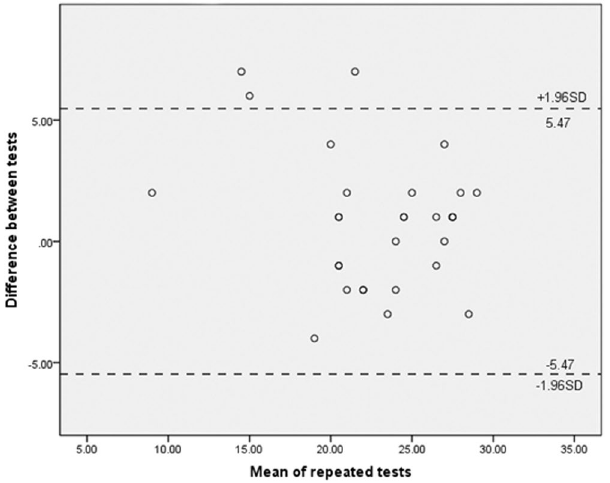
Figure 1. The Bland-Altman plot for the MMSE reliability assessment. The graph displays a scatter diagram of the test-retest differences plotted against the averages of the two tests. Horizontal dotted lines were drawn at the limits of agreement, which were defined as the mean difference ± 1.96 times the standard deviation of the differences. For repeated measurements, the expected mean difference was set to